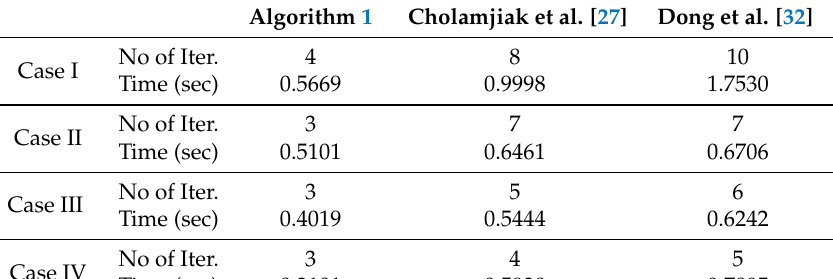
Table 3. Computational result for Example 3.